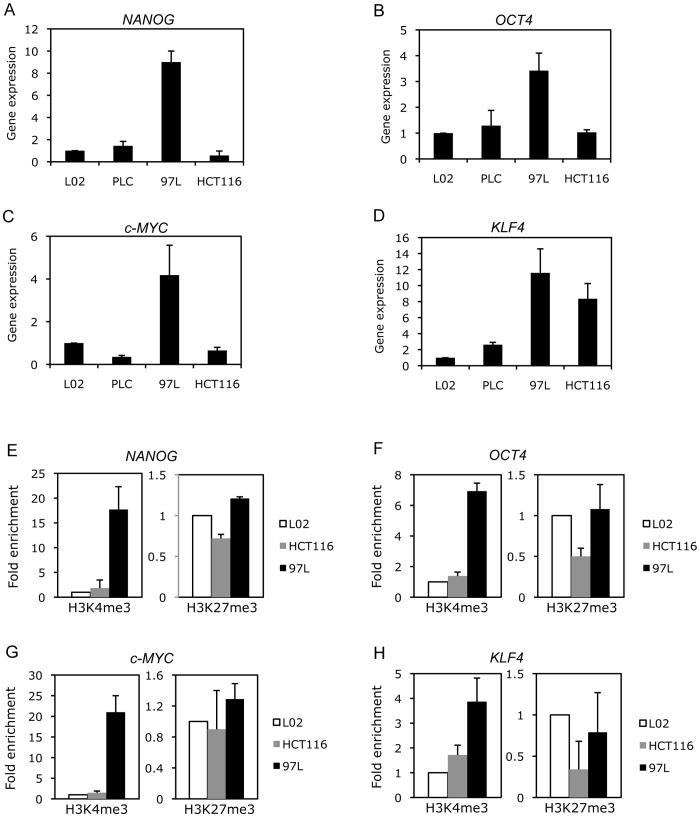
A correlation between pluripotency-associated gene expression and histone modification patterns in normal and cancer cells.Expression levels of (A) NANOG, (B) OCT4, (C) c-MYC, and (D) KLF4 genes were determined in L02, PLC, 97L, and HCT116 cells by qRT-PCR analysis, normalized with the reference gene 18S. The gene expression was normalized to L02 sample, which was defined as 1. Data are the mean ± SD obtained from 2 to 3 experiments with duplicates. Enrichment of histone modification H3K4me3 and H3K27me3 at the promoter regions of pluripotency-associated genes (E) NANOG, (F) OCT4, (G) c-MYC, and (H) KLF4 were measured in L02, 97L, and HCT116 by ChIP analysis. Data are represented as fold enrichment and normalized with input and mock IgG controls. The fold enrichment was relative to L02 sample, which was defined as 1. Data are represented with mean value obtained from two ChIP experiments with error bars of standard derivation.